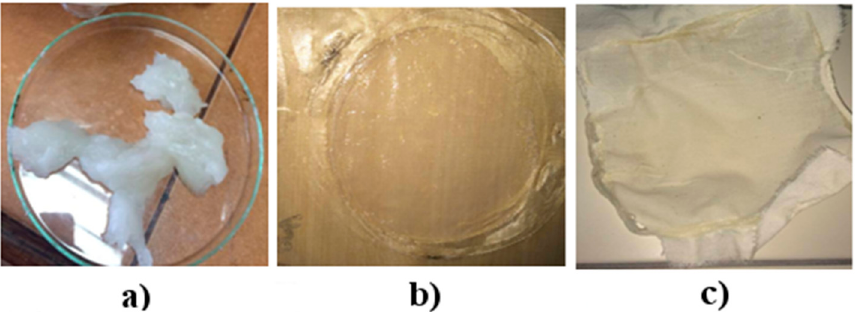
Figure 1. Starch mixture before pressing ( a ), starch film ( b ), cellulose-starch composites ( c